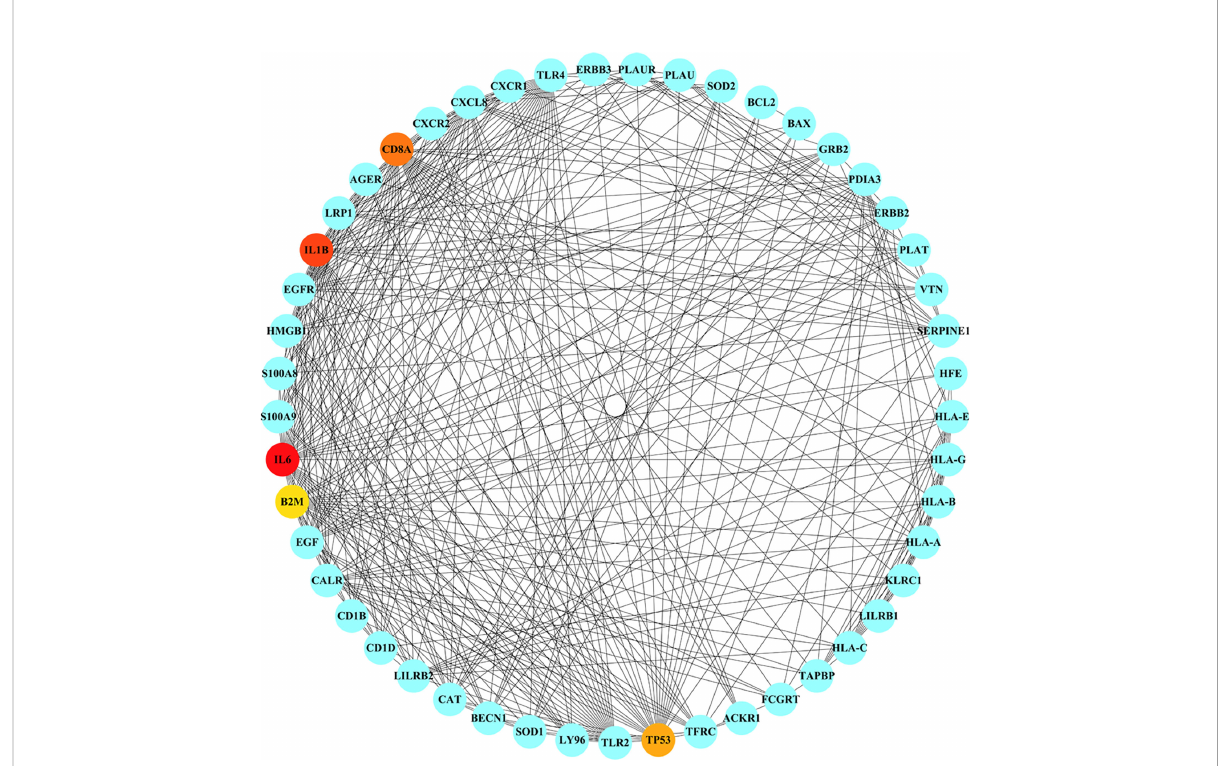
FIGURE 6 Detection of hub genes from the PPIs network of common genes. The highlighted 5 hub genes, based on their degree, are IL6, IL1B, CD8A, TP53, CXCL8. The network has 49 nodes and 373